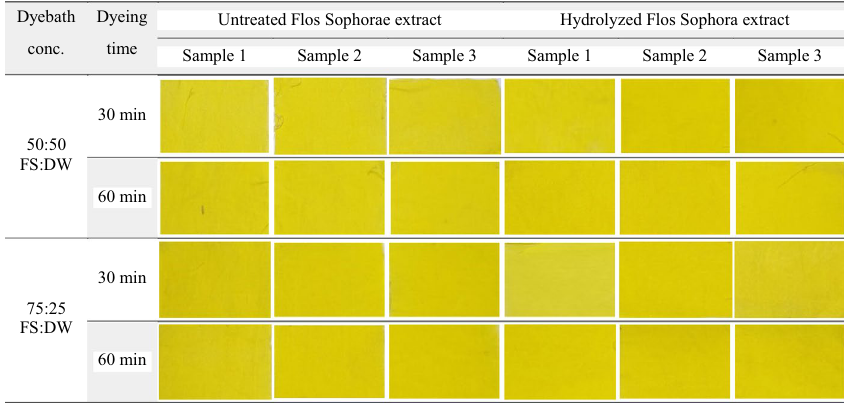
Table 9 Photographs of cotton dyed with Rutin and Quercetin standards Dye